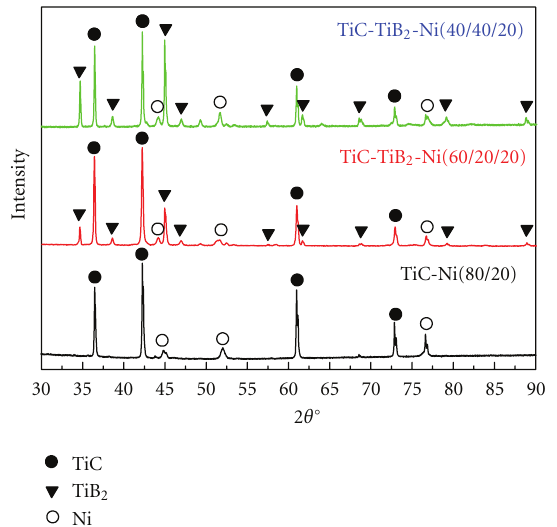
Figure 3: XRD patterns of samples with 20vol% Ni and di ff erent volume fraction of TiC and/or TiB 2 .